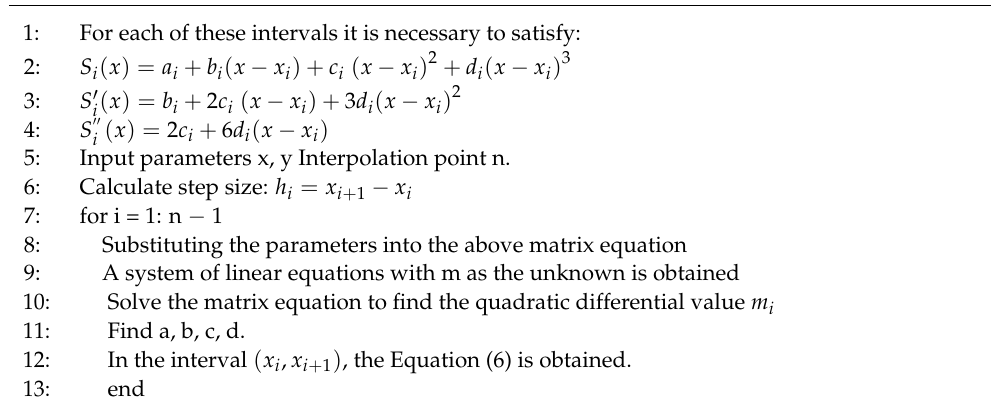
Algorithm 1 Triple spline